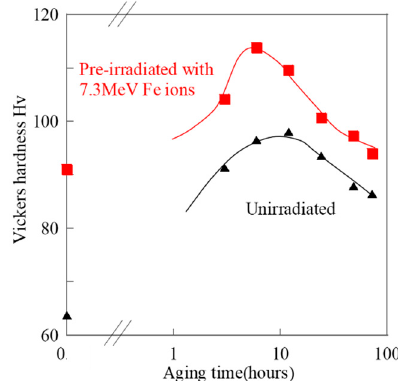
Figure 15. Vickers hardness as a function of aging time for specimen pre-irradiated with 7.3 MeV Fe ions to the fluence of 5.65 × 10 15 / cm 2 . Data for unirradiated specimen are also shown. Aging temperature is 453 K.